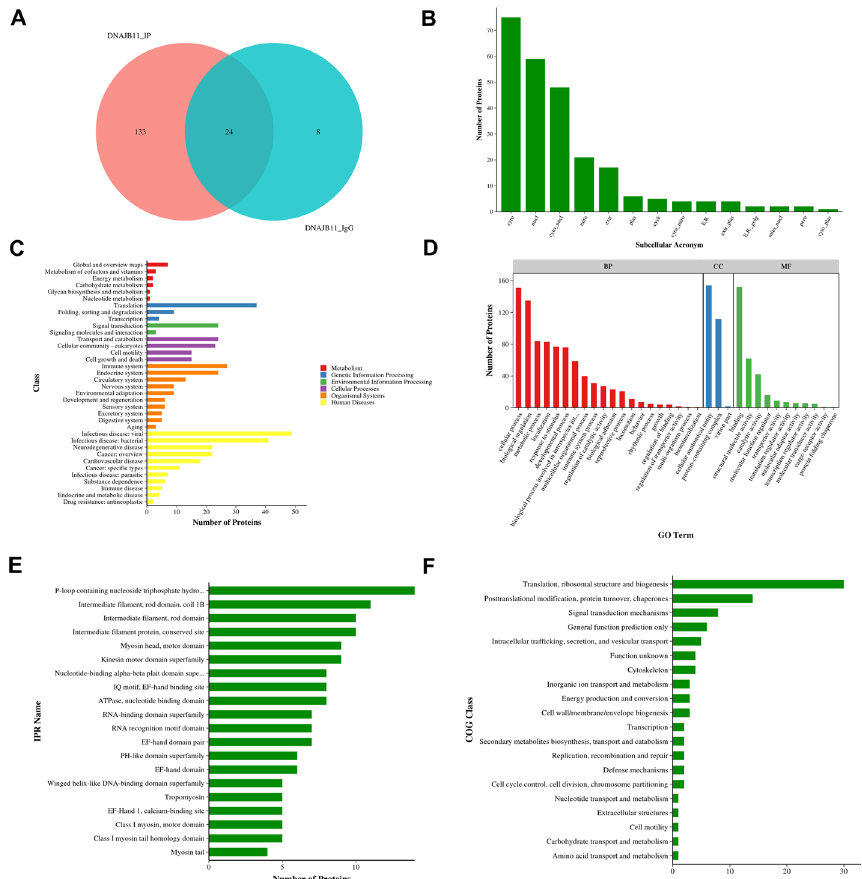
Fig. 5 Function enrichment analysis of DNAJB11 co-expression proteins. A Venn diagram of proteins from IgG and DNAJB11 group. B The subcellular localization was predicted with the WoLF PSORT database. C KEGG analysis D GO analysis. E Protein domains were predicted with InterProScan. F Cluster of orthologous groups of proteins (COG) analysis was carried out for the identified proteins